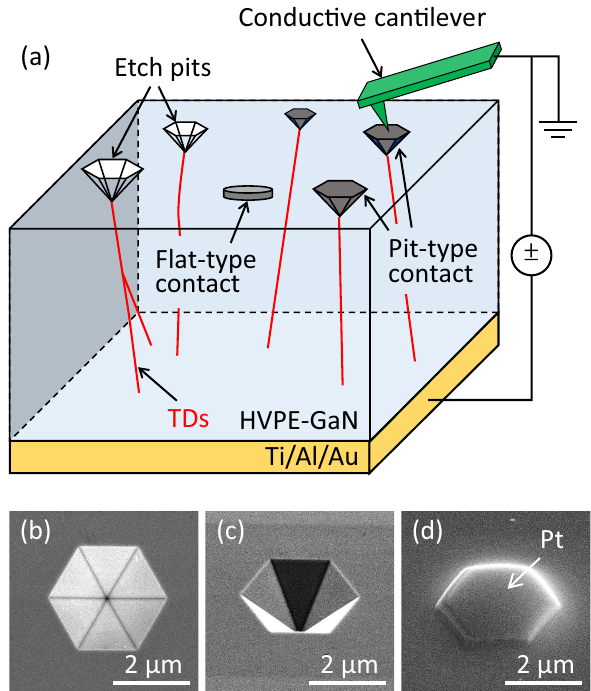
Figure 1. ( a ) Schematic of the C-AFM measurement setup used to evaluate the electrical properties of local Schottky contacts. Pit- and flat-type contacts were formed at etch pits related to TDs and at surface sites where no etch pits were present, respectively. Scanning electron microscopy images showing ( b ) a plan-view and ( c ), ( d ) bird’s-eye views of a typical etch pit ( b ), ( c ) before and (d) after the deposition of